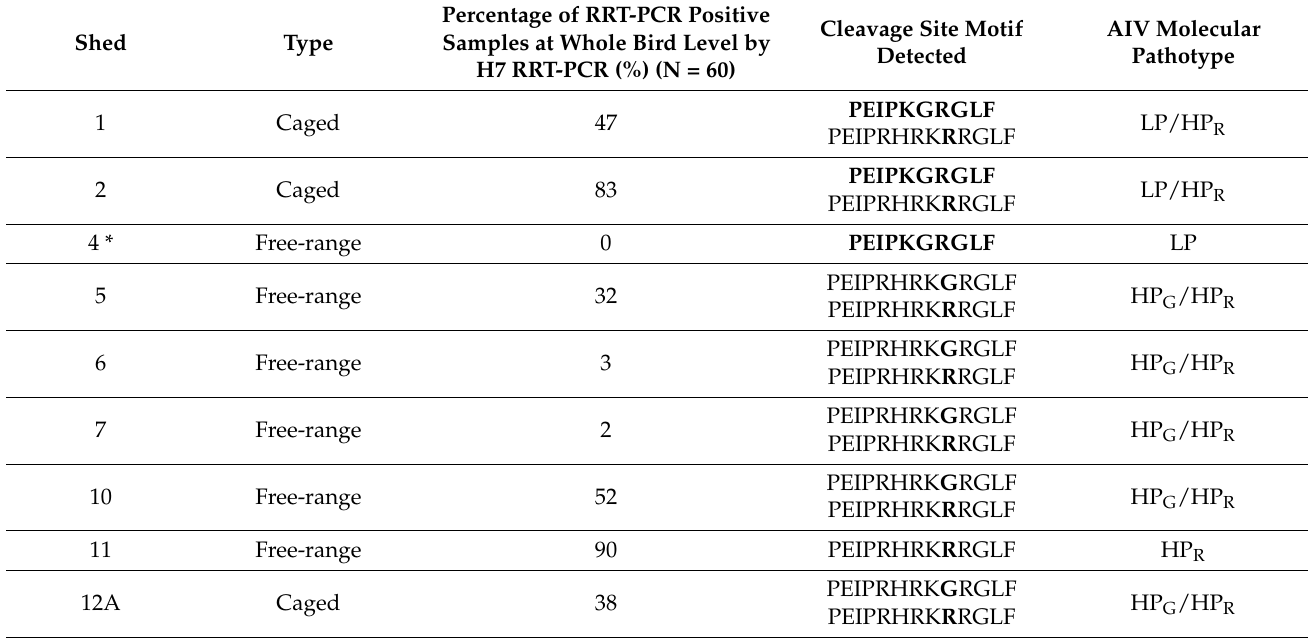
Table 3. RRT-PCR and sequencing results from Sample Set 3. HA CS motifs for each shed were determined based on sequencing of individual swabs. HP G ; HA CS motif PEIPRHRK G RGLF, HP R ; HA CS motif PEIPRHRK R RGLF, LP; HA CS motif